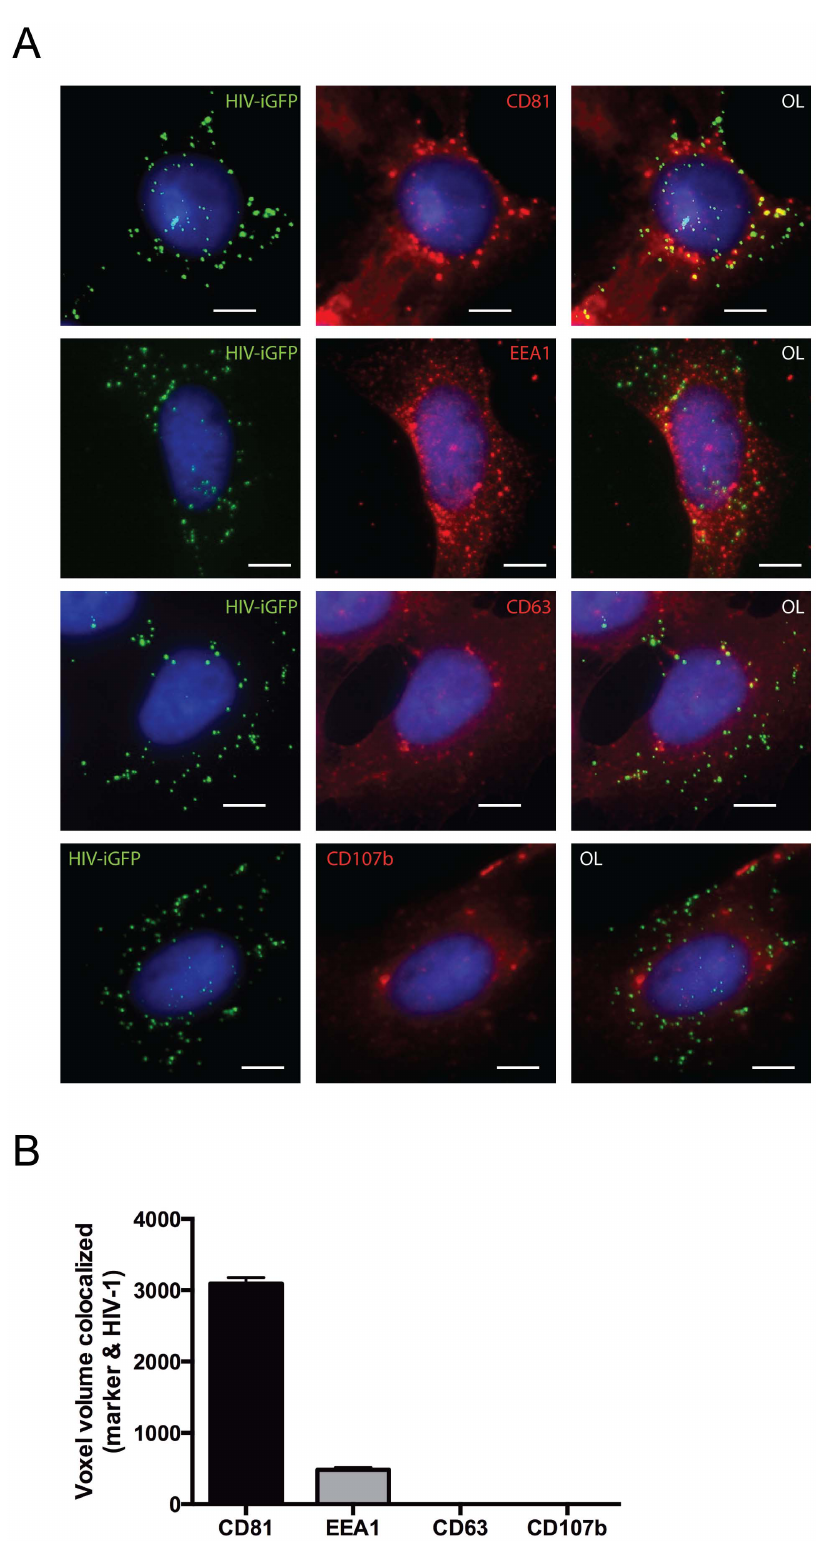
Figure 2. HIV-1 colocalizes with CD81-lined vesicle compartments in astrocytes. (A) SVG astrocyte cells were infected with an EGFP content-labelled HIV-1 YU2 virus (green) and samples were harvested at 135 mins post-infection. Cells were stained with the vesicle/endosomal markers CD81, EEA1, CD63 or CD107b (red) and nuclei counterstained with DAPI (blue). Panels represent the individual fluorescent channels with the